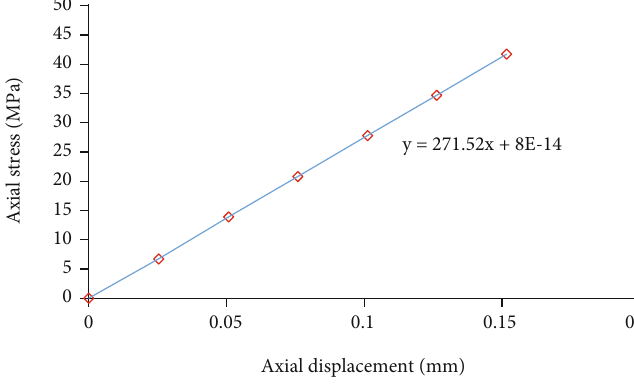
Figure 15: Halliburton laboratory experimental data [1].